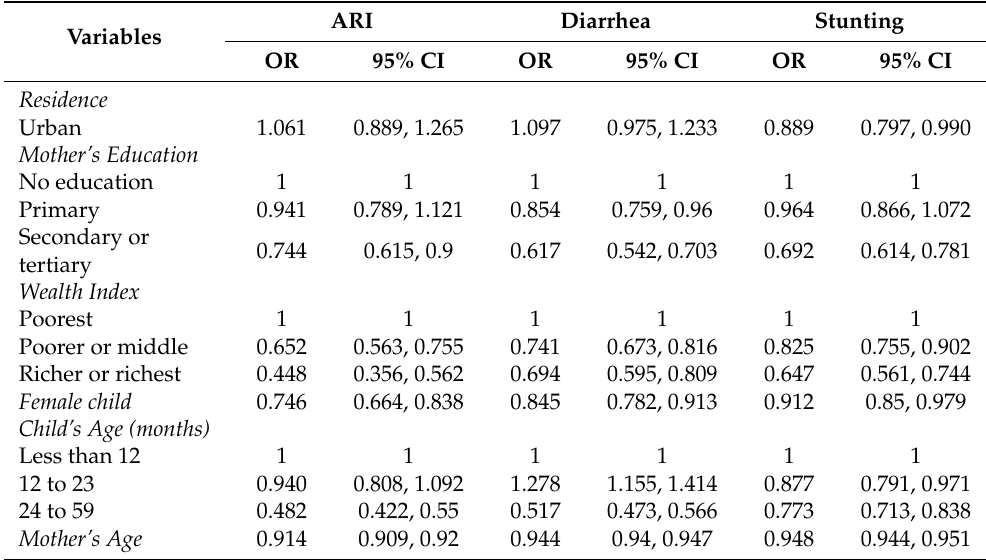
Table 5. The odds ratio estimates of covariate effects and their 95% Credible Interval for 2013.